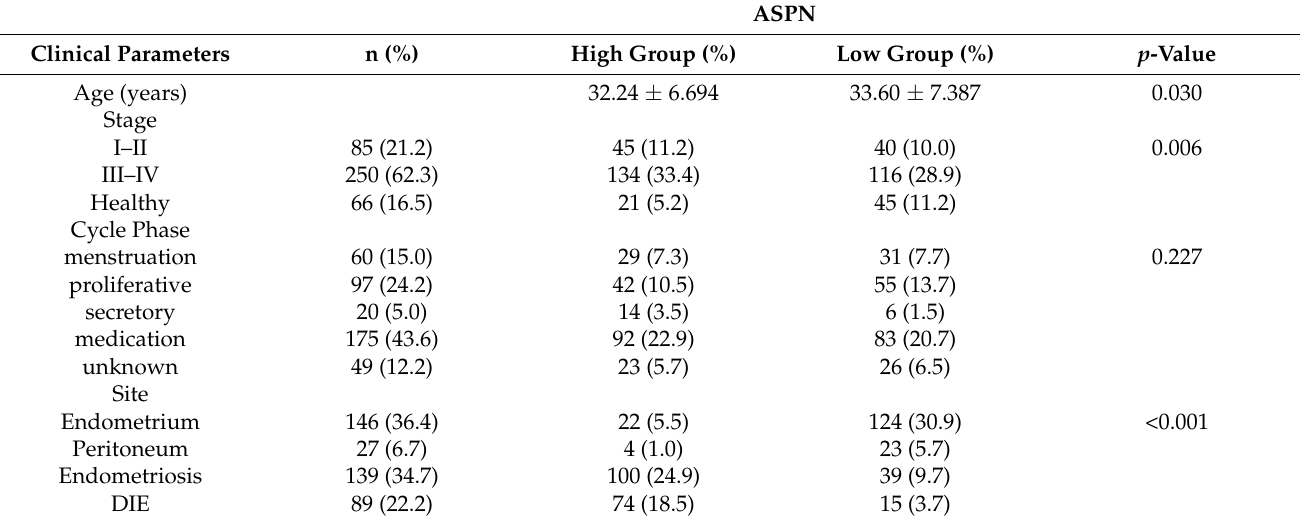
Table 4. Clinical characteristics of endometriosis patients with low and high expression of ASPN.